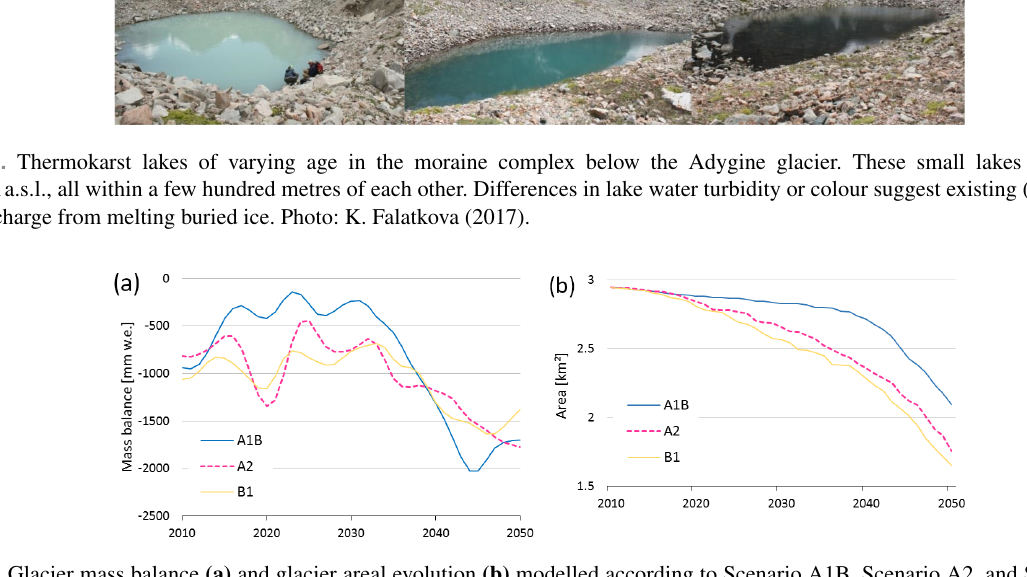
Figure 6. Glacier mass balance (a) and glacier areal evolution (b) modelled according to Scenario A1B, Scenario A2, and Scenario B1 for the period 2010–2050. Data smoothed using 10-year low-pass